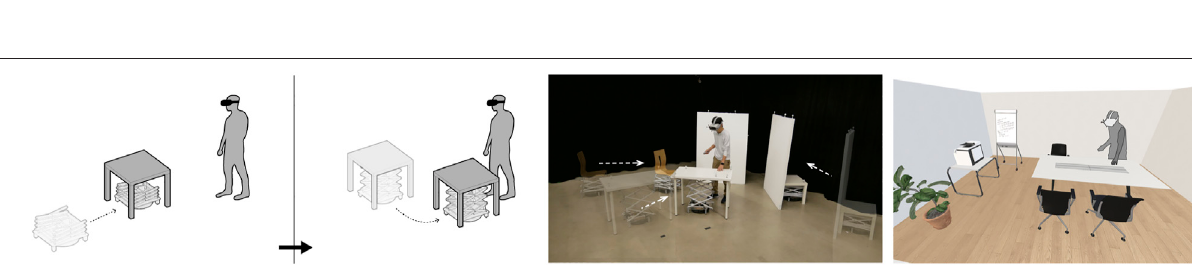
Frontiers in Robotics and AI |